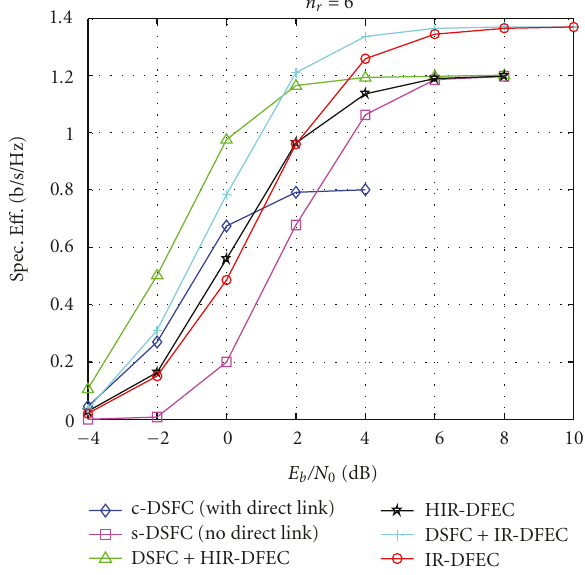
Figure 11: Spectral e ffi ciency versus E b /N 0-direct —modified D1— n d = 2, n r =